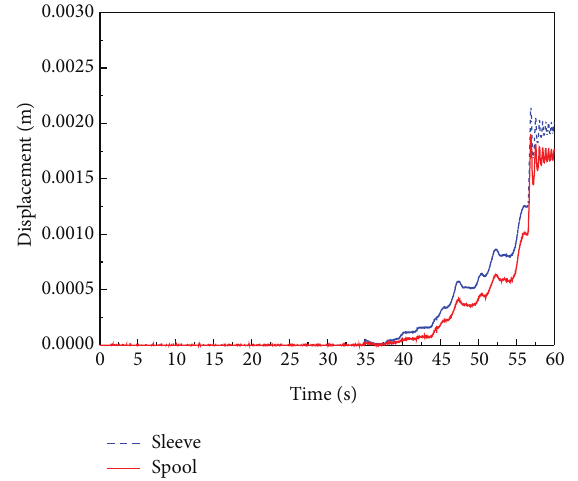
Figure 27: Simulation results of the displacement of the sleeve and spool of the regulator with modified counterbalance